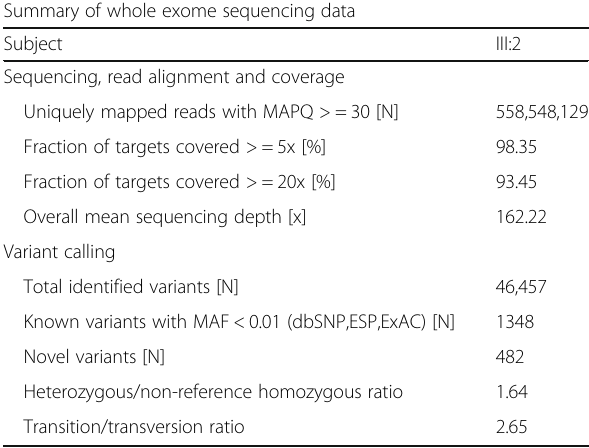
Table 1 Summary of whole exome sequencing and variant